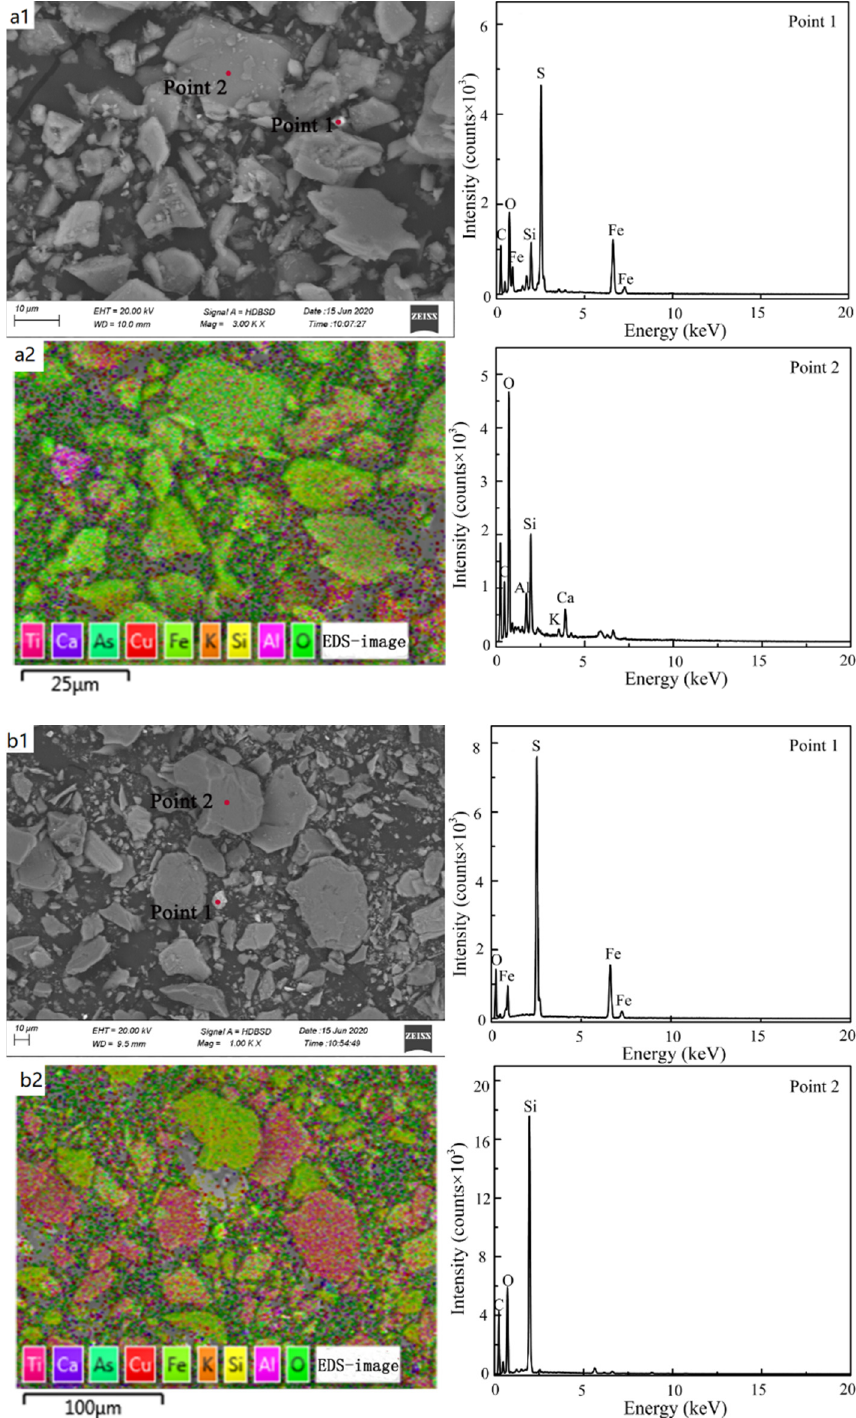
Figure 9. SEM-EDS analysis of cyanide tailings ( a1 , a2 ) before dynamic leaching, and ( b1 , b2 ) after dynamic leaching.